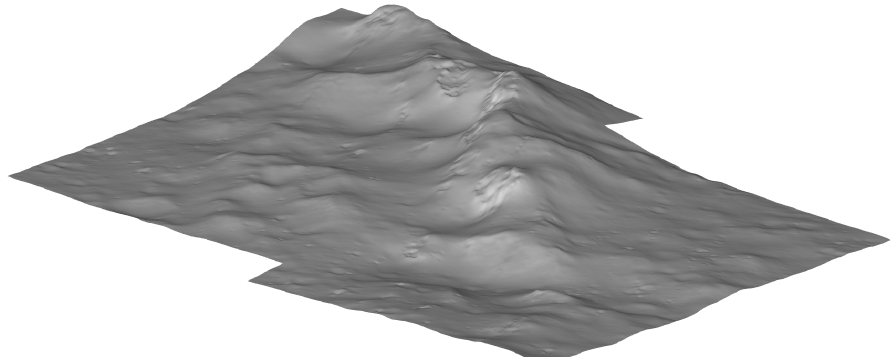
Figure A2. Rendered SfS DTM. For illustration purposes, the z-axis is multiplied by a factor of 2.